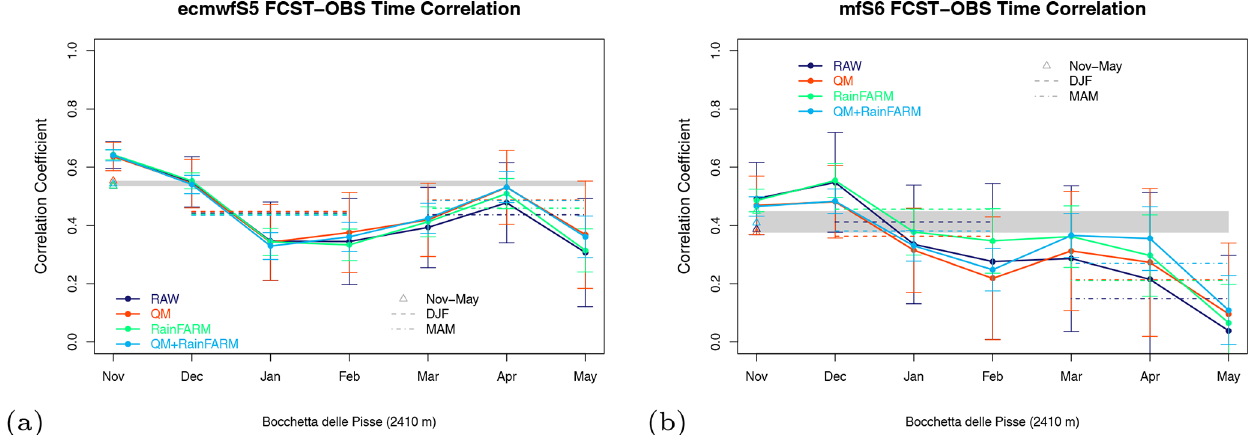
Figure 6. Pearson’s correlation coefficient between forecasts of ensemble-mean, monthly mean snow depth obtained with (a) ECMWFS5 and (b) MFS6 forcing (FCST) and observations (OBS) at the site of Bocchetta delle Pisse. Forecasts are initialized on 1 November and run with a lead time of 7 months. Coloured dots represent the correlation for each month and each experiment, dashed horizontal (dotted-dashed) lines represent DJF (MAM) values, and the grey rectangle and the four coloured triangles represent seasonally averaged (November–May) values. Error bars represent the 5th–95th percentile range of the distribution of 1000 bootstrap samples as described in Sect. 2.7.